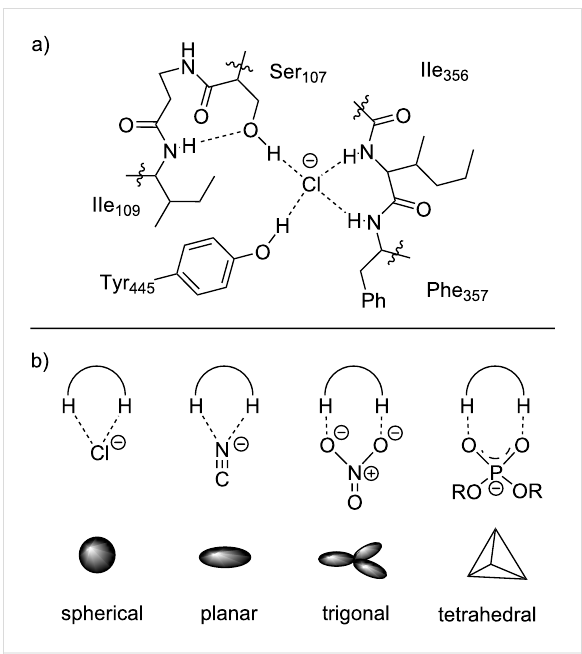
Figure 1: a) Binding interactions in the chloride channel of E. coli. and b) examples of chloride, cyanide, nitrate and phosphate anions with their respective